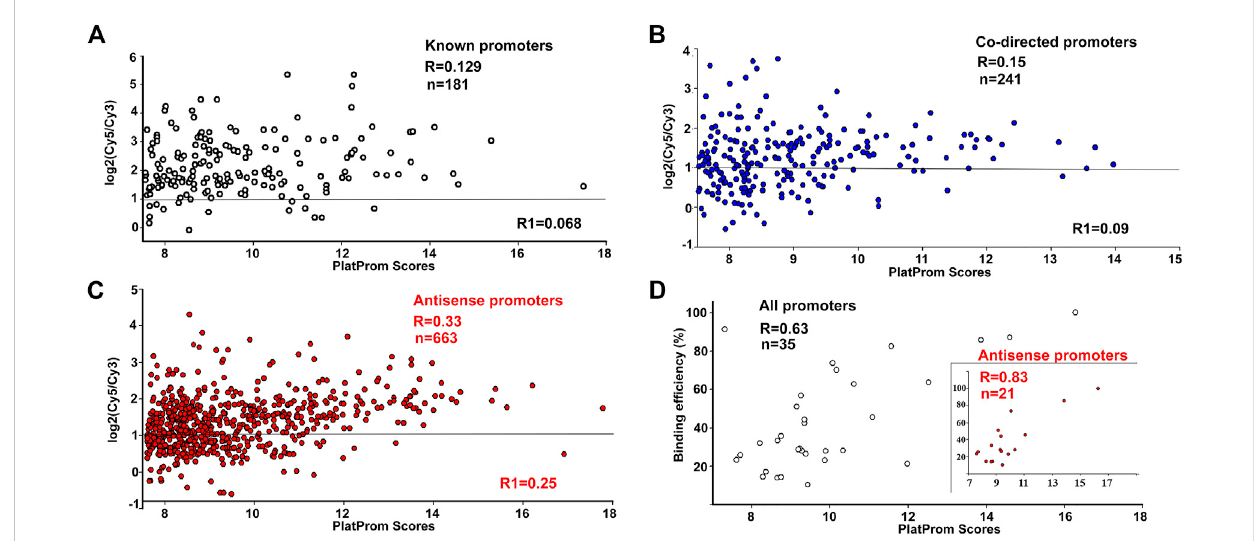
FIGURE 1 Correlationbetweenpromoterstrength insilico (PlatPromscore),anditsabilitytobindRNApolymerase invivo (A – C) and invitro (D) .ChIP-chipdata forRarefrom(Herringetal.,2005),forR1,from(Reppasetal.,2006).Plotsareshownonlyforthedatafrom(Herringetal.,2005).Horizontallinesindicate the cut-off level for the ChIP-chip